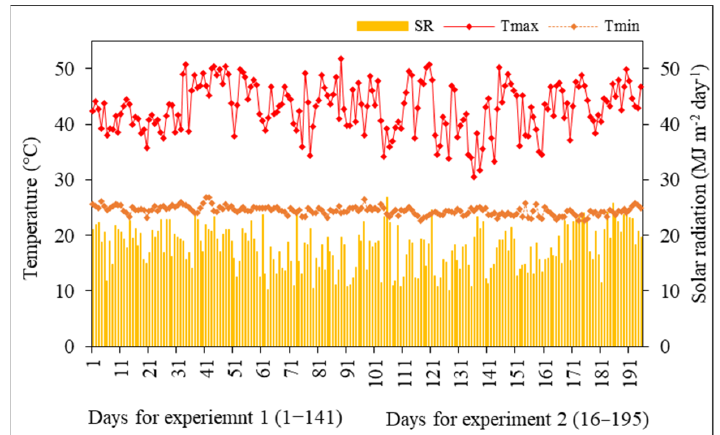
Figure 2. Mean daily maximum and minimum temperatures (°C) and solar radiation (MJ m –2 day − 1 ) for the potential experiment (1) and the yield assessment experiment (2).